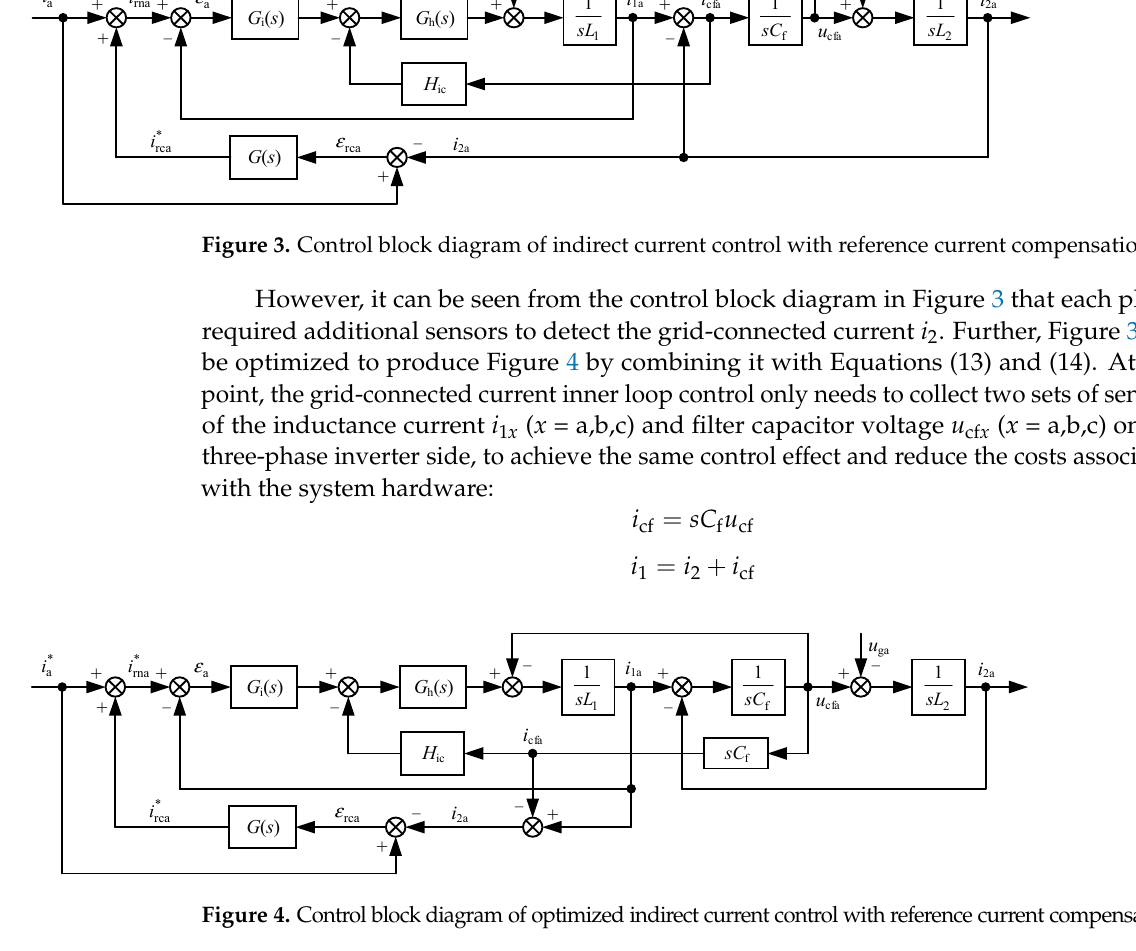
Figure 3. Control block diagram of indirect current control with reference current compensation.